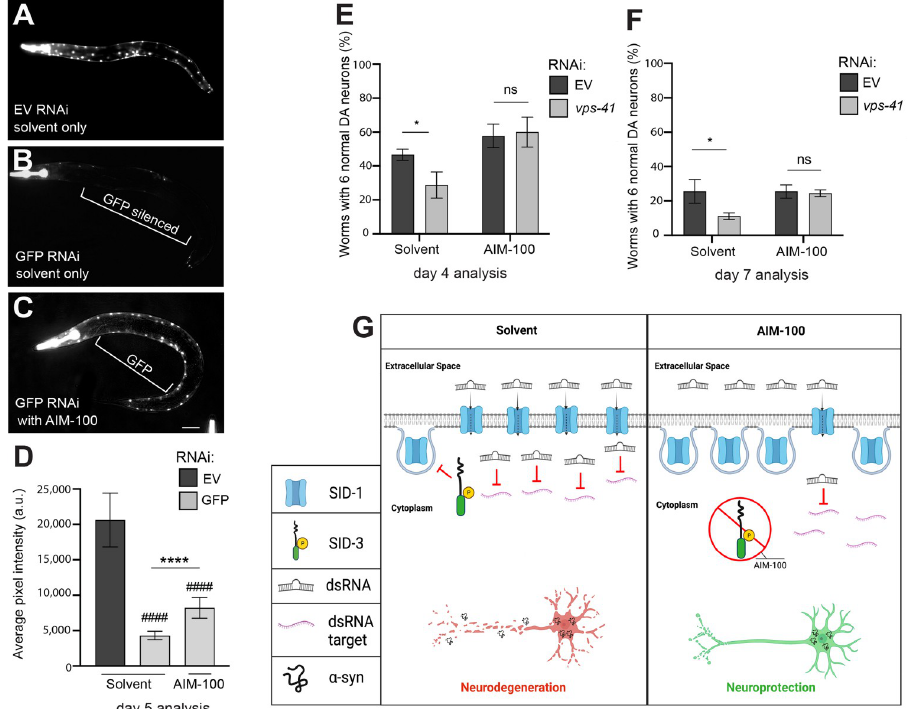
Fig 2. AIM-100 reduces dsRNA silencing in body wall muscle and decreases DA neurodegeneration. ( A-D ) AIM- 100 diminishes RNAi silencing in body wall muscle cells. RNAi in representative worms overexpressing GFP in body wall muscle cells, with and without the SID-3 inhibitor AIM-100 (100 μ M) in 0.1% ethanol solvent. Worms were tested on day 5 post-hatching. ( A ) Empty vector (EV) RNAi in worms overexpressing GFP in body wall muscle cells exposed to the solvent. ( B ) GFP RNAi in worms overexpressing GFP in body wall muscle cells exposed to the solvent. ( C ) GFP RNAi in worms overexpressing GFP in body wall muscle cells and administered AIM-100. Scale bar, 50 μ m. (D) Average pixel intensity was measured at day 5 post-hatching in worms in the same conditions outlined in (A-C) . Values represent mean + S.D. (n = 30 worms per group per replicate, 3 independent replicates). Two-Way ANOVA with Tukey’s post hoc analysis was used to compare all groups to each other; Symbols above bars are in comparison to the solvent group with EV RNAi; #### P < 0.0001. Symbols above brackets are in comparison to bars indicated. ���� P < 0.0001. ( E, F ) DA neurodegeneration levels in an RNAi-sensitive α -syn model background designed to allow knockdown of genes solely in DA neurons (strain UA196) and analyzed at days 4 and 7 post-hatching. Worms were either exposed to the 0.1% ethanol solvent control or AIM-100 (100 μ M), and within each of these conditions, mock RNAi (empty vector) or vps-41 (positive control) RNAi was performed. Values represent mean + S.D. (n = 30 worms per genotype per replicate, 3 independent replicates). Two-way ANOVA with Tukey’s post hoc analysis was used to compare all conditions to each other; ns P � 0.05, � P < 0.05. Values represent mean + S.D. (n = 30 worms per genotype per replicate, 3 independent replicates). ( G ) An illustration (created with Biorender.com) depicting model scenarios for the import of dsRNA (targeting vps-41 , an established control for DA neurodegeneration when knocked down) into DA neurons via SID-1 in transgenic animals expressing α -syn, either in the presence (left pane) or absence (right pane) of treatment with the selective inhibitor of SID-3 activity, AIM-100. The left pane represents SID-3 actively blocking the endocytosis of SID-1 in the absence of AIM-100 (solvent only), therefore maintaining dsRNA transport for the silencing of target genes, such as vps-41 , which enhances DA neurodegeneration when knocked down. In contrast, the right pane displays a scenario that explains the observed inhibition of SID-3 by AIM-100 treatment seen when α -syn is expressed in DA neurons; in this scenario AIM-100 reduces the activity of SID-3 and allows for endocytosis of SID-1, thereby resulting in less SID-1 on cell surfaces and reduced dsRNA import into cells. This leads to the stability of endogenous vps-41 transcripts and enhanced resistance to α -syn-induced neurodegeneration observed, in accordance with the established function of